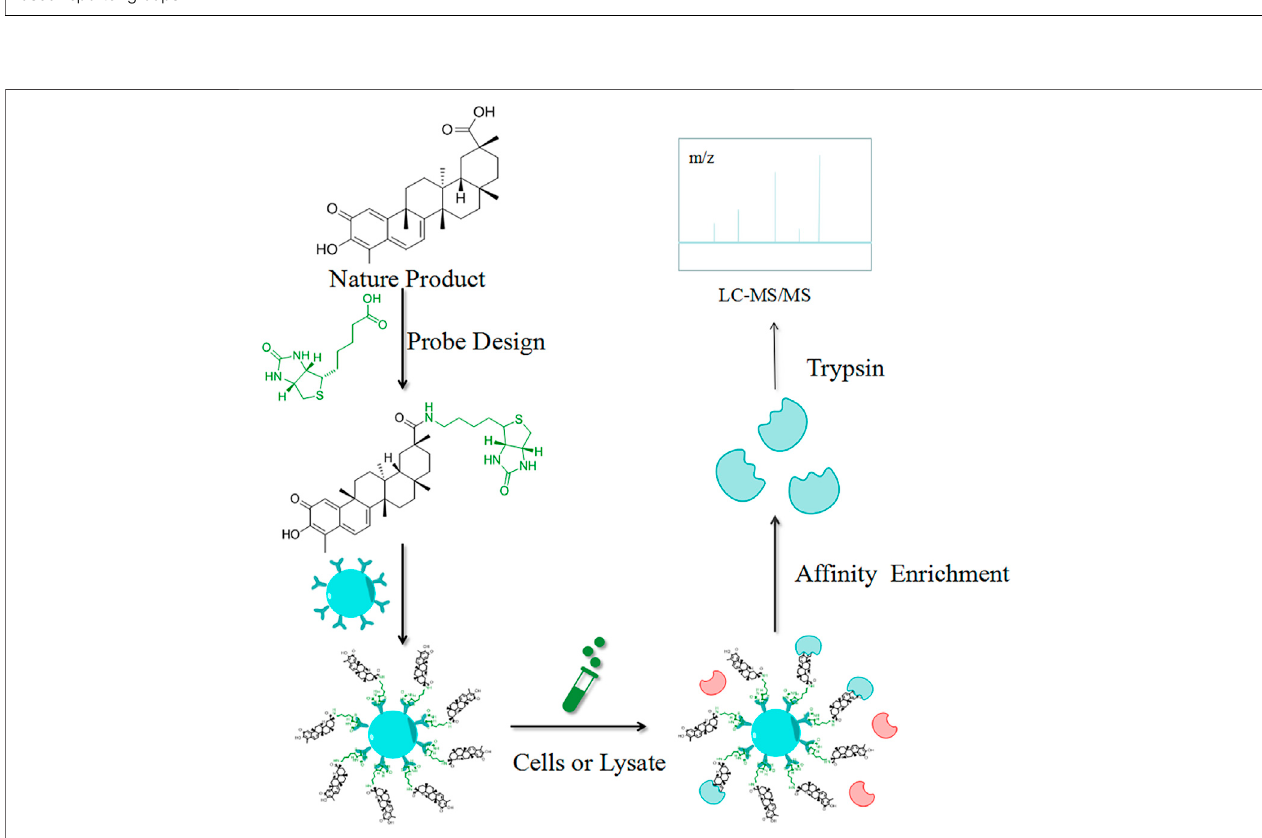
target protein (Chang et al., 2016) ; 2) the reporter group consists of the tag, which is used for rapid target – probe complex positioning, enrichment, and puri fi cation; and 3) the linker connecting the active and reporter groups, providing enough space for the two and ensuring that no interference with each other (Ma et al., 2018).